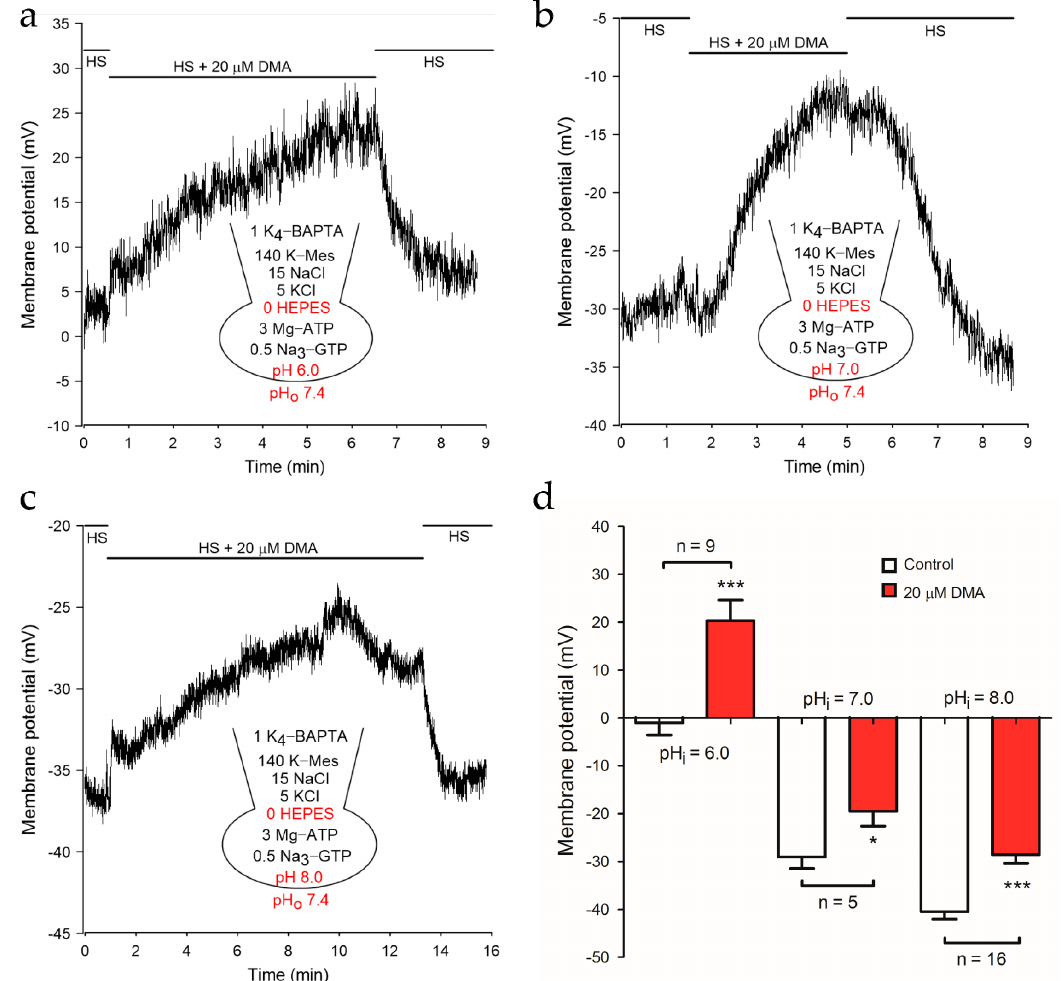
Figure 3. The membrane potential of mouse spermatozoa was depolarized by DMA in the pipette solution with no pH buffer. Sperm membrane potential was reversibly depolarized by 20 μ M DMA at pH i 6.0 ( a ), pH i 7.0 ( b ), pH i 8.0 ( c ). Representatives of three current-clamp recordings are shown respectively. HS solution containing 135 mM Na + was employed to maintain NHEs activity. ( d ) Mean amplitudes of membrane potential before and after the treatment of DMA at pH i 6.0 ( n = 9), pH i 7.0 ( n = 5) and pH i 8.0 ( n = 16). Data are expressed as mean ± SEM. * p < 0.05, *** p < 0.001 (paired t -test).